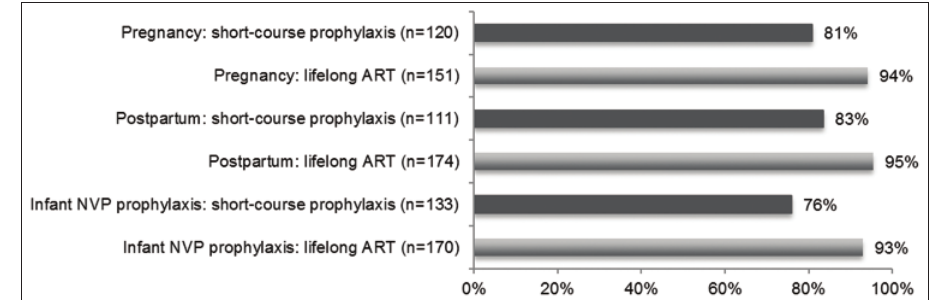
Figure 1 : Proportion of participants reporting at least 80% drug adherence during each time period in the PMTCT cascade of